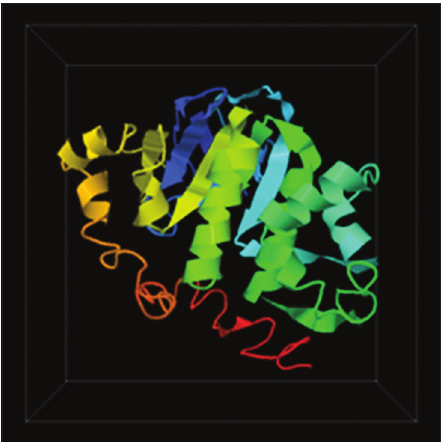
Figure-3: The prediction model of the highest C-score (−0.66) Trypanosoma evansi Multidrug resistance protein E